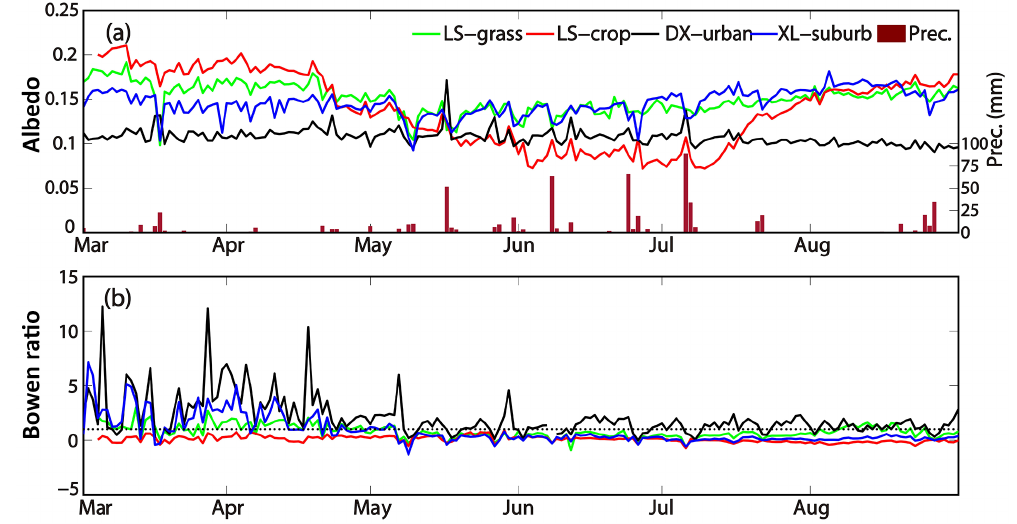
Figure 11. Daily variation in (a) albedo and (b) Bowen ratio at the four sites in Nanjing from March to August